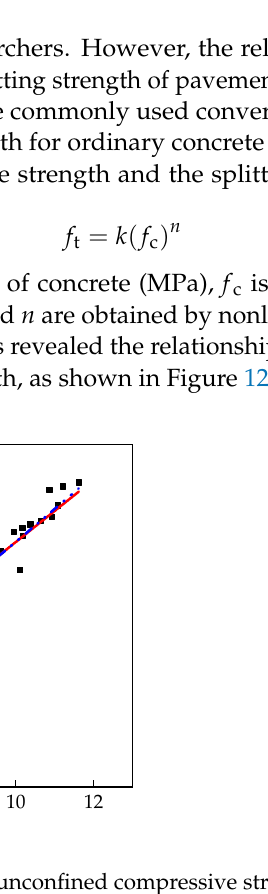
Figure 12. Relationship between the unconfined compressive strength and splitting strength. After fitting the test data with the power function and linear function, Equations (3) and (4) were obtained, respectively.